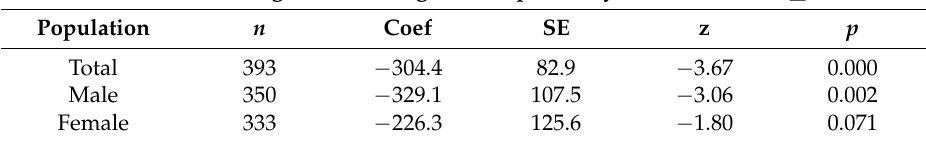
Table A4. Adjusted Poisson log-linear model with arsenic dose rate (mg/Kg/day), 1.1 L/day, ≥ 80% dependency, As(Max) ≤ 50, and ND = 1/2